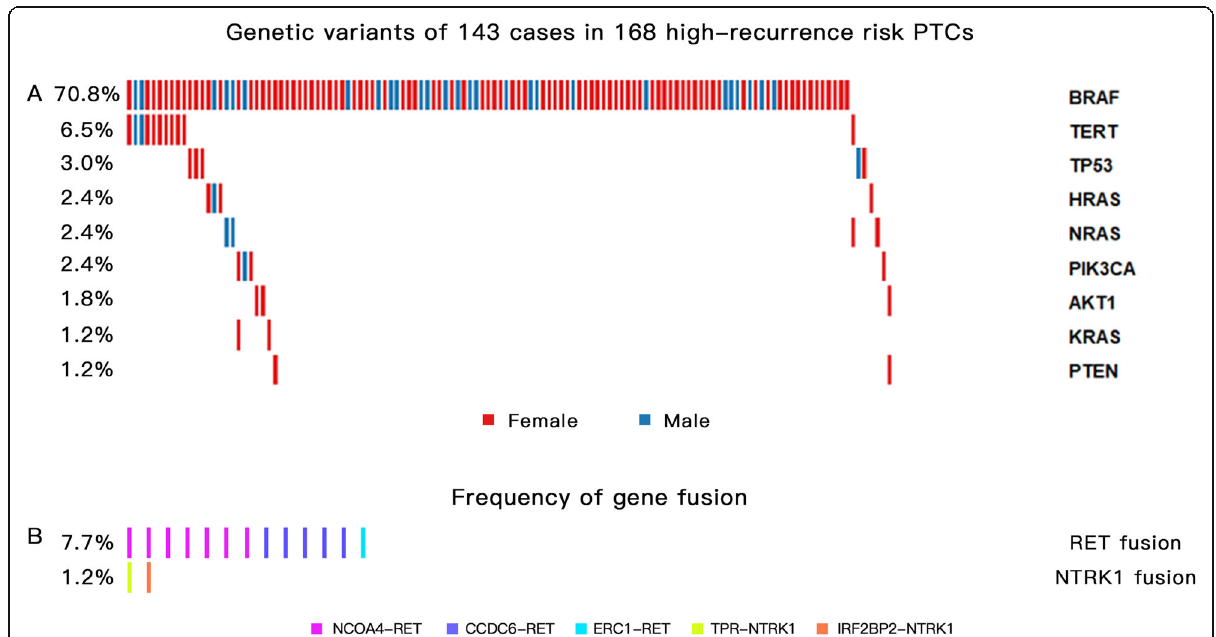
Fig. 1 Genetic variants of 143 PTC patients in southern Chinese populations. One hundred forty-three PTC patients with driver gene mutation, including 128 cases with point mutation or promoter mutation, 15 cases with gene fusion. a Allelic frequency of BRAF V600E and other mutations in 128 patients with at least one mutation, gene fusion is excluded. b 3 types of RET fusion and 2 types of NTRK1 fusion